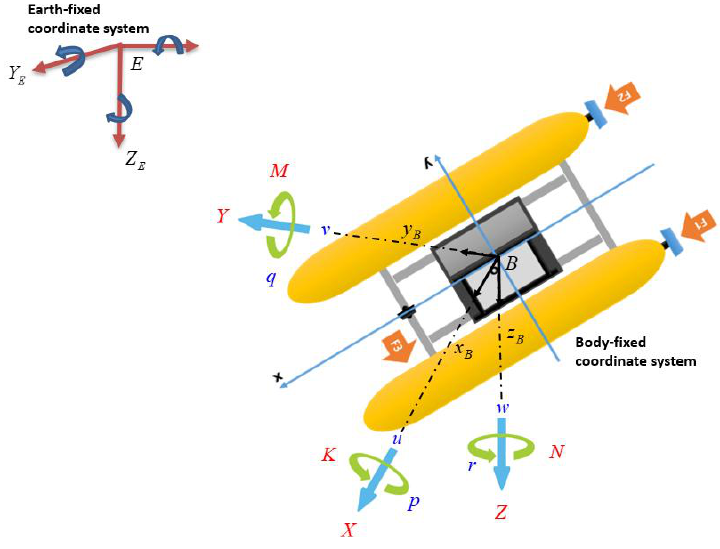
Figure 7. Motion variables for USV.